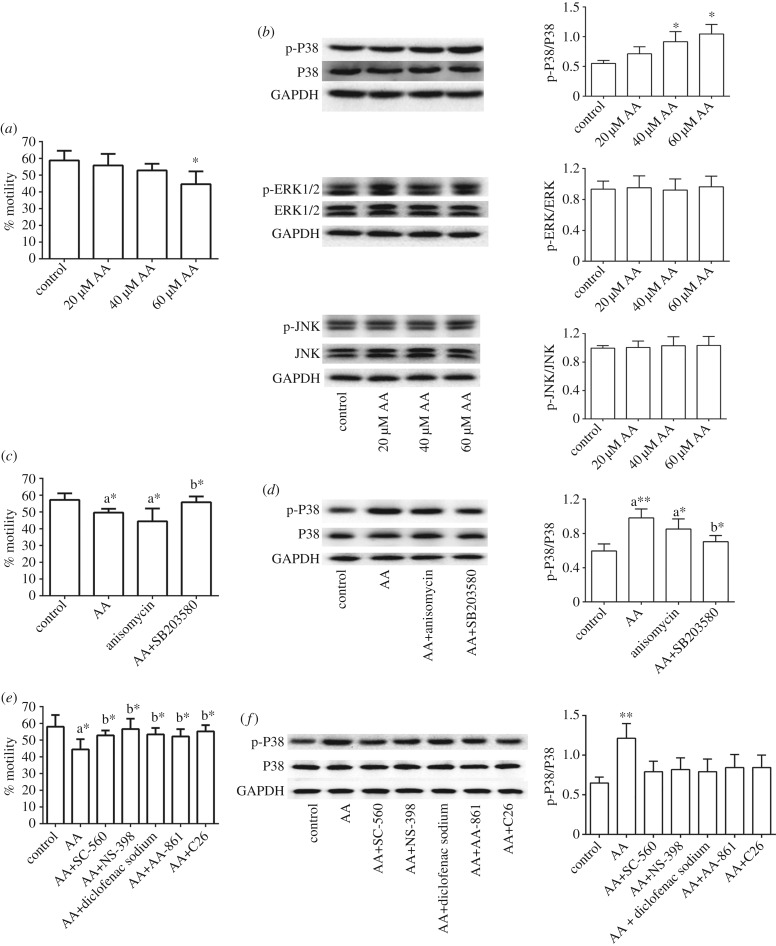
In vitro molecular mechanism study. (a) Percentages of motile spermatozoa after AA administration (*p < 0.05, compared with the control group). (b) Protein levels of MAPKs after AA treatment. Results are representative of three independent experiments (*p < 0.05, **p < 0.01, compared with the control group; Y-axis represents the intensity ratio of p-P38/P38, p-ERK/ERK and p-JNK/JNK, respectively, after adjustment by GAPDH). (c) Per cent motile spermatozoa after incubation of AA and specific MAPK inhibitors (a*p < 0.05, compared with the control group; b*p < 0.05, compared with the AA group). (d) AA-induced P38 activation was abolished by P38 inhibitor (a*p < 0.05, a**p < 0.01, compared with the control group; b*p < 0.05, compared with the AA group; Y-axis represents the intensity ratio of p-P38/P38 after adjustment by GAPDH). (e) Per cent motile spermatozoa after treatment with AA and AA metabolic pathway inhibitors (a*p < 0.05, compared with the control group; b*p < 0.05, compared with the AA group). F, AA-induced P38 activation was blocked by selective COX-1 inhibitor, selective COX-2 inhibitor, non-selective COX-1 and COX-2 inhibitor, 5-LOX inhibitor and CYP2J2 inhibitor (**p < 0.01, compared with the control group; Y-axis represents the intensity ratio of p-P38/P38 after adjustment by GAPDH).